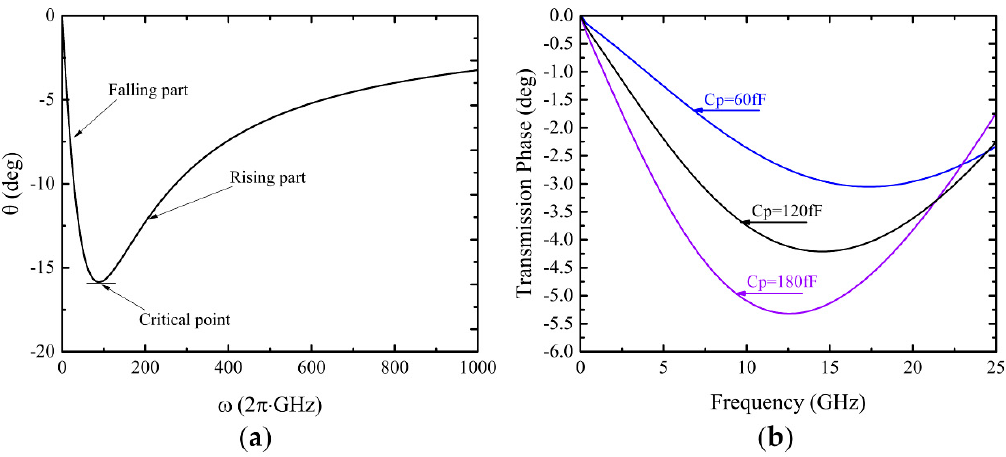
Figure 3. ( a ) The theoretical mathematical analysis image of Equation (1); ( b ) The practical simulation results of the transmission phase of the phase correction branch in 0.13 µ m SiGe BiCMOS.